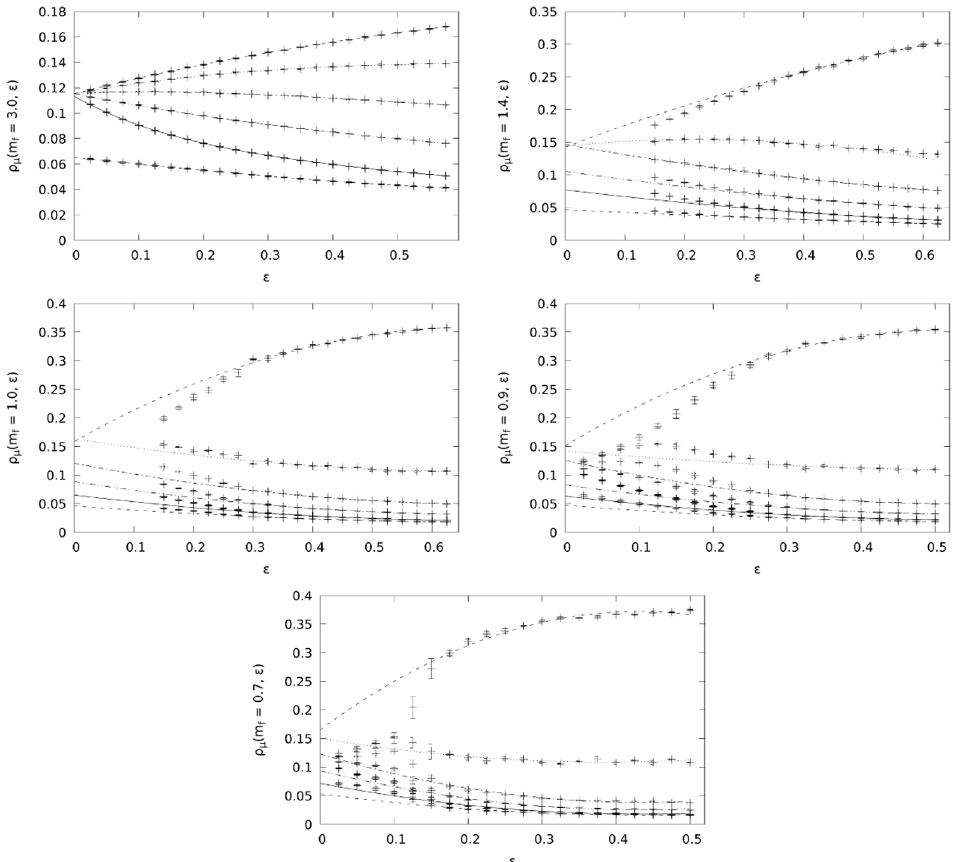
Figure 2 . The (cid:26) (cid:22) ( m f ; (cid:15) ) in eq. (3.13) are plotted against (cid:15) for m f = 3 : 0 (Top-Left), m f = 1 : 4 (Top-Right), m f = 1 : 0 (Middle-Left), m f = 0 : 9 (Middle-Right) and m f = 0 : 7 (Bottom). We use m (cid:22) = (0 : 5 ; 0 : 5 ; 0 : 5 ; 1 ; 2 ; 4 ; 8 ; 8 ; 8 ; 8) for m f = 3 : 0 and m (cid:22) = (0 : 5 ; 0 : 5 ; 1 ; 2 ; 4 ; 8 ; 8 ; 8 ; 8 ; 8) for the other values of m f . The continuous lines are polynomial (cid:12)ts in (cid:15) . For m f = 3 : 0 a quartic (cid:12)t is performed, whereas for the other values of m f the (cid:12)ts are quadratic in (cid:15) . In the m f = 3 : 0 plot, the curves from top to bottom are ( (cid:26) 1 + (cid:26) 2 + (cid:26) 3 ) = 3, (cid:26) 4 , (cid:26) 5 , (cid:26) 6 , (cid:26) 7 and ( (cid:26) 8 + (cid:26) 9 + (cid:26) 10 ) = 3. For the other plots, the curves from top to bottom are ( (cid:26) 1 + (cid:26) 2 ) = 2, (cid:26) 3 , (cid:26) 4 , (cid:26) 5 , ( (cid:26) 6 + (cid:26) 7 ) = 2 and ( (cid:26) 8 + (cid:26) 9 + (cid:26) 10 ) =